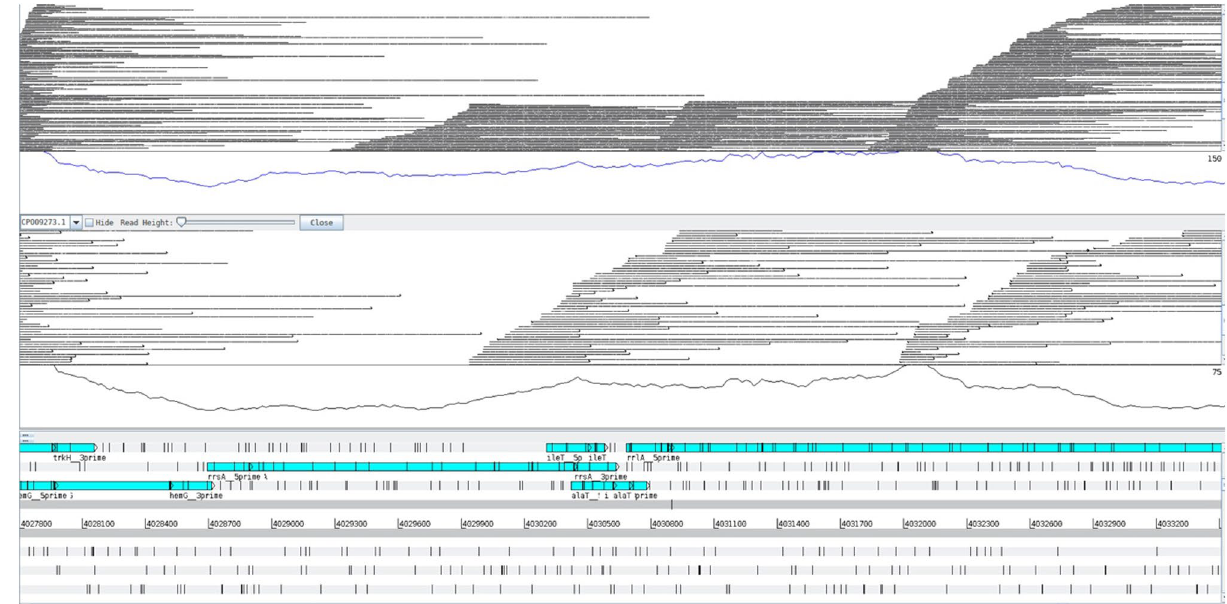
Figure 5. Long-reads mapped uniquely to a single copy of a repeating ribosomal RNA gene cluster of over 5 kb. In the E. coli genome, the longest repeating nucleotide sequences are those of the ribosomal RNA operons, of which there are seven copies, each of over 5 kb in length. These are, therefore, a good test of the ability of LoRTIS to identify insertion sites uniquely within long repeating sequences. A genetic map of the relative rRNA gene positions is shown at the bottom of the panel as blue arrowhead boxes. Above this, each panel depicts the long-reads, each shown as a fine horizontal line, that map uniquely within this repeat